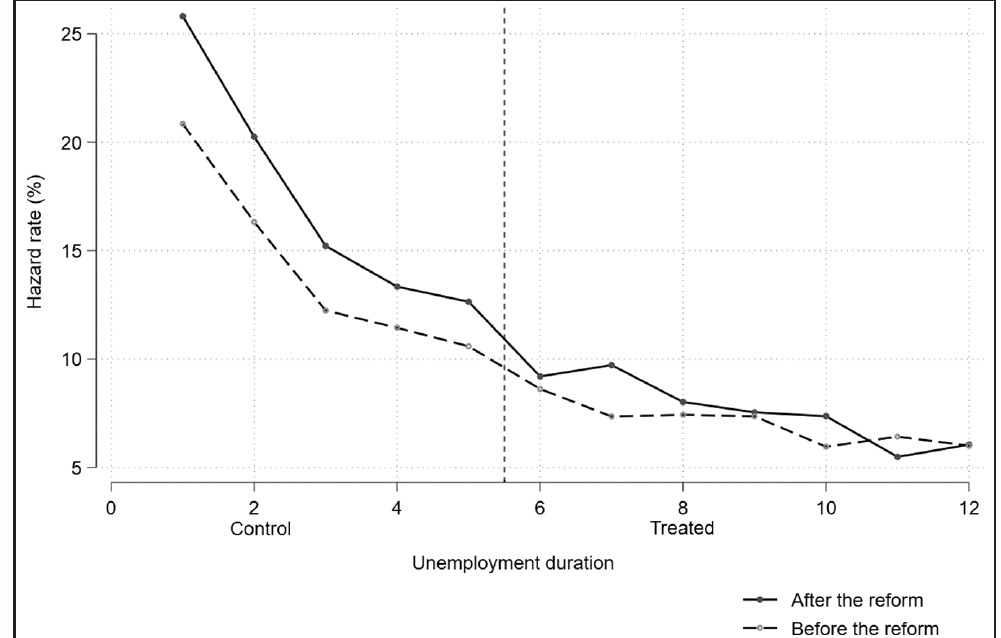
Exploring the effect of the abolition of the subsidy in a DiD framework: the job- finding rate of jobseekers aged 45–48 years as a function of elapsed unemploy- ment duration, before and after the